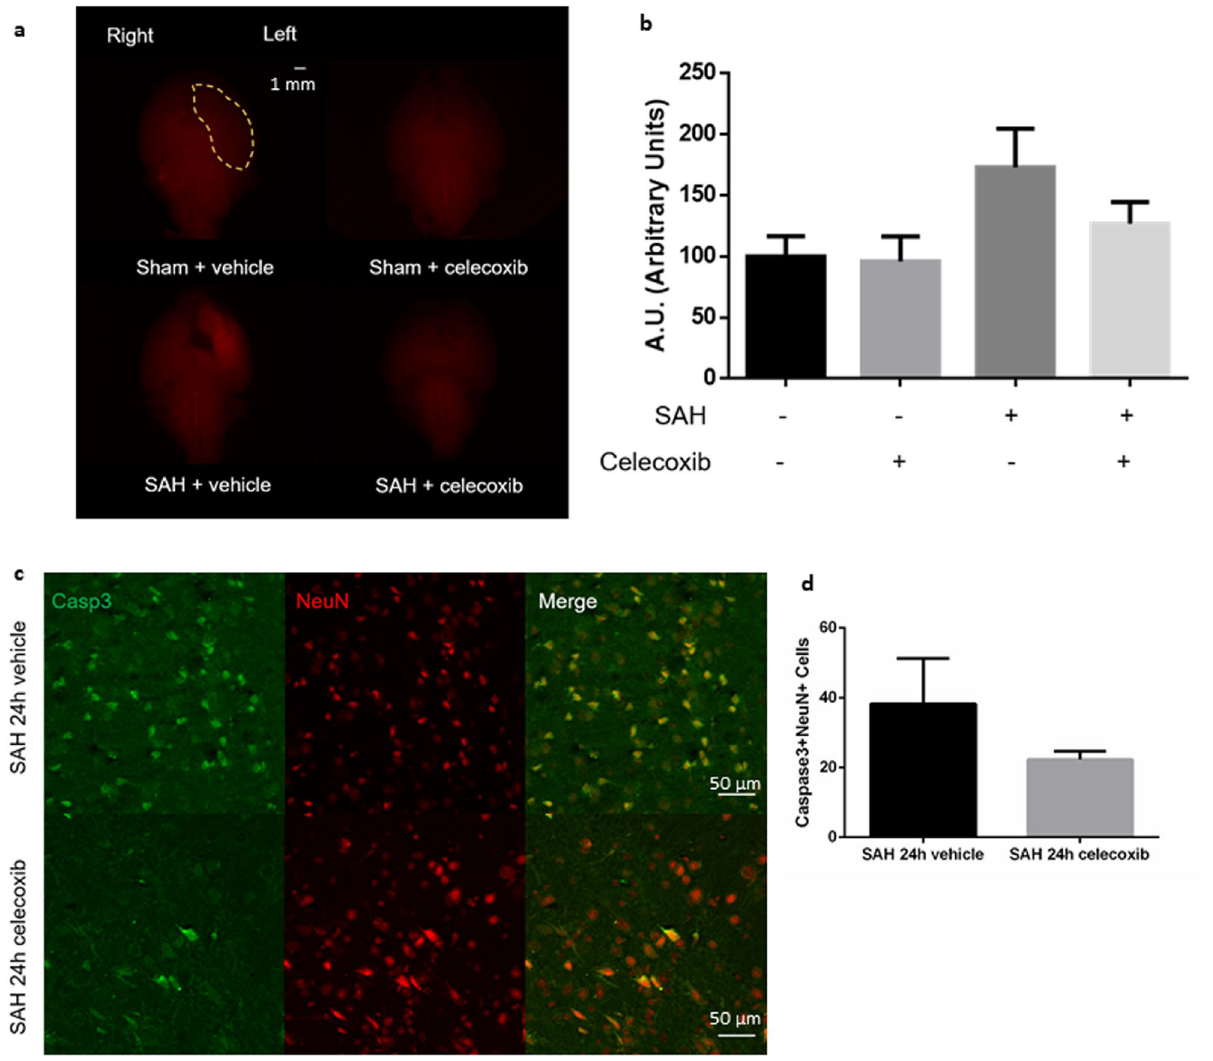
Figure 7. Celecoxib treatment after experimental SAH. ( a ) Whole brain fluorescent imaging from ventral perspective 24 h after SAH or sham procedure, treated with selective Cox2 inhibitor celecoxib or vehicle. Left ventral region demarcated by yellow marking. Cadaverine dye fluorescence shown in red. ( b ) Quantification of cadaverine dye fluorescence in left ventral region. ( c ) Merged double-stained immunofluorescent confocal microscopy of coronal brain slices 24 h after SAH treated with celecoxib or vehicle (NeuN (neuronal marker) = red, Caspase-3 (apoptosis marker) = green). Apoptotic neurons noted in yellow. ( d ) Semi-automated apoptotic neuronal count from left ventral region of coronal brain slices. n = 3–4 per group. Data presented as means ± SEM. One-way ANOVA with Holm-Sidak post-hoc correction. * p < 0.05.